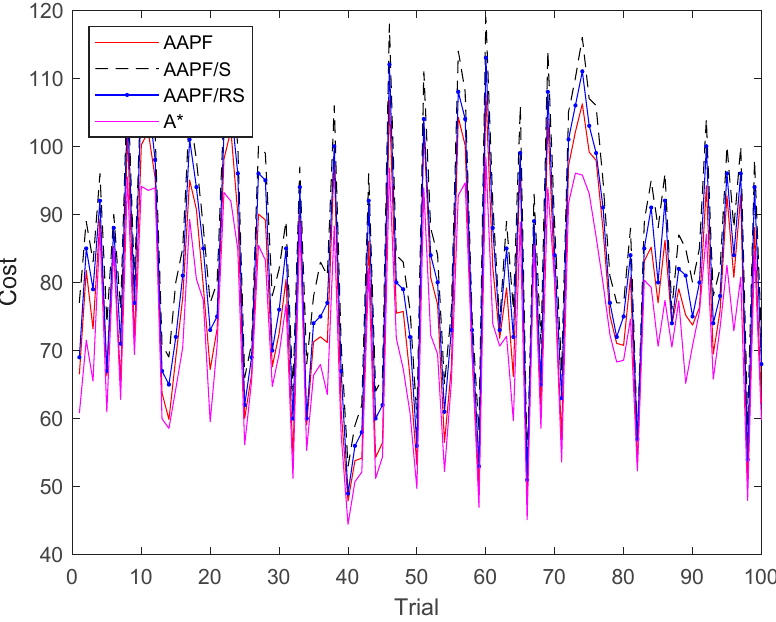
Figure 11. Simulation results on path planning cost.